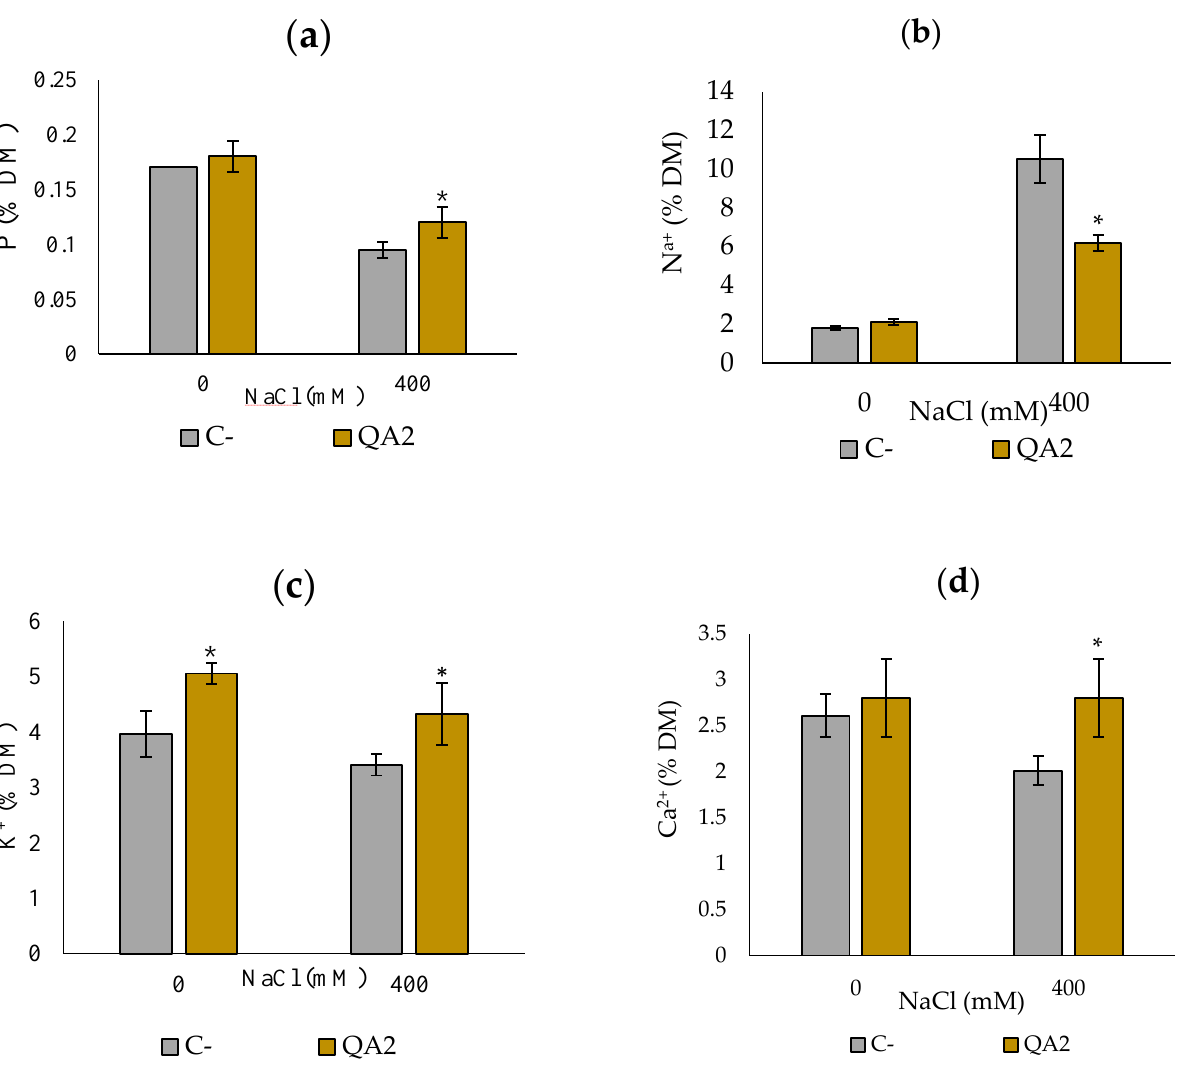
Figure 7. Effect of salt stress induced by NaCl and B. velezensis QA2 inoculation on the uptake of phosphorus (P) and ions by quinoa plants ( a ) P ( b ) Na + ( c ) K + ( d ) Ca 2+ . The values represent means of replicates (n = 4) ± standard deviations. Asterisks in superscript indicate the significant difference to the control at 95% between treatments.